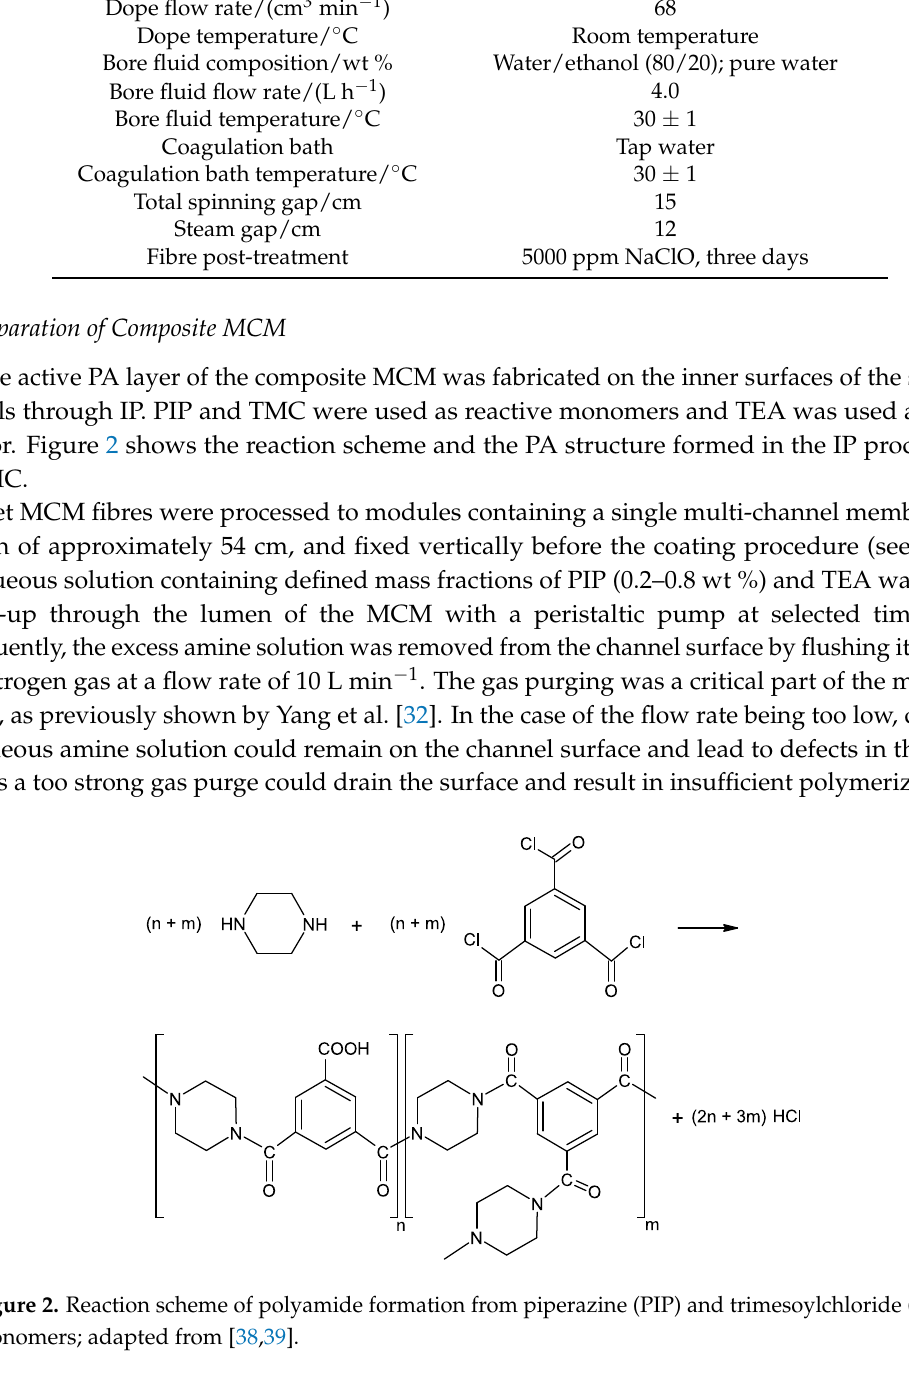
Table 1. Dope composition, spinning parameters and post-treatment of produced MCM.